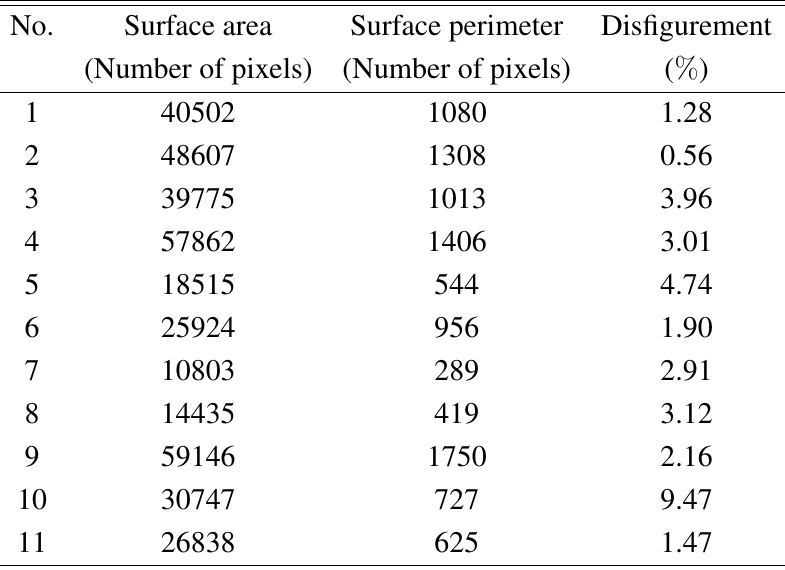
Table 1. Shape features of some tobacco